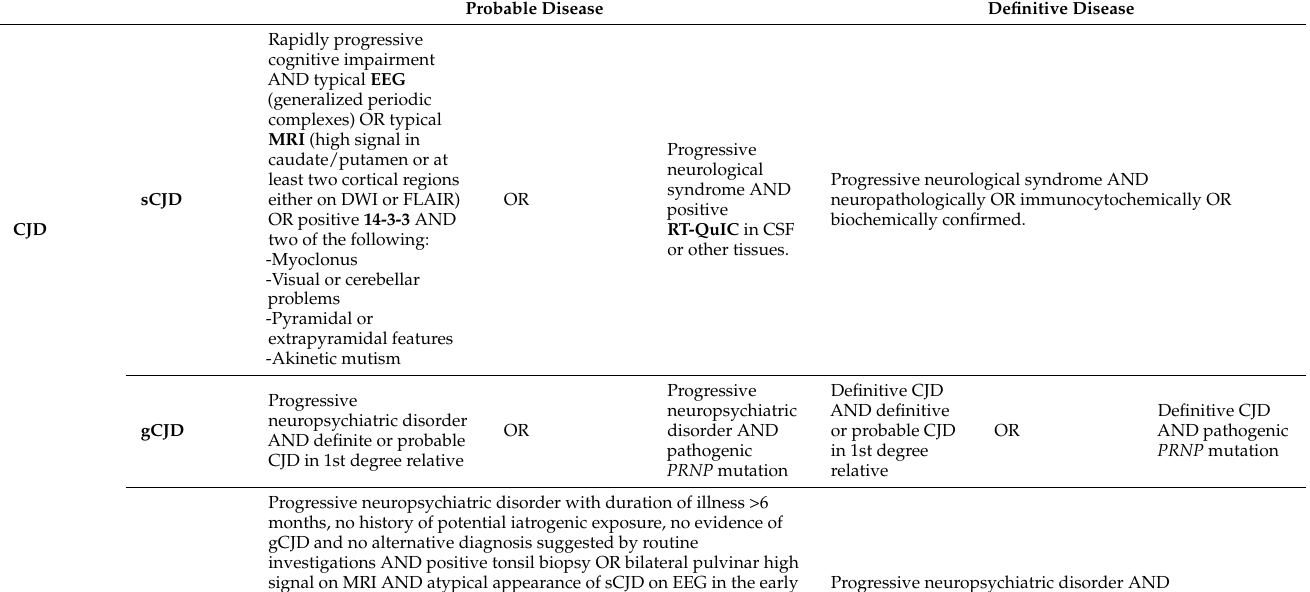
Table 1. Diagnostic criteria for probable and definite categories of prion